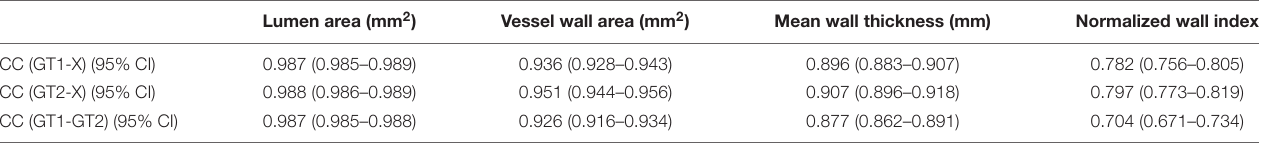
TABLE 3 | The agreement of lumen and vessel wall measurements (ICC values with 95% CI) between automatic and manual segmentation methods and between two manual reads.